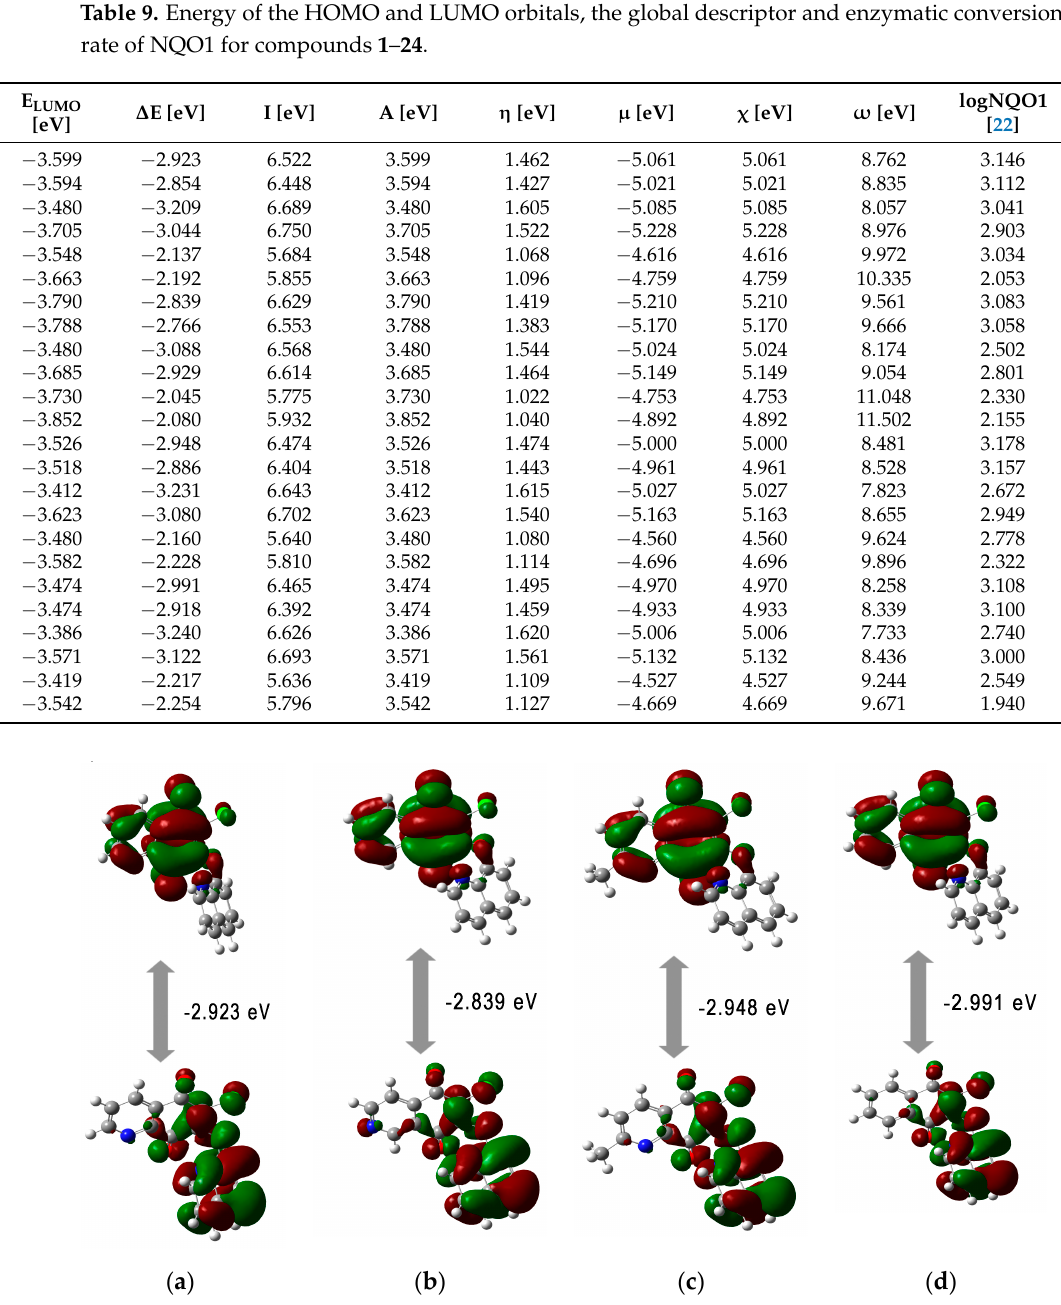
Figure 6. The HOMO-LUMO orbitals for compounds: ( a ) 1 ; ( b ) 7 ; ( c ) 13 ; ( d ) 19 . The multilinear regression (MLR) Equation (6) was used to determine the enzymatic conversion rate of NQO1 (logNQO1 calc ) based on the quantum chemical properties, such as energy of LUMO (E LUMO ) orbital and electrophilicity index ( ω